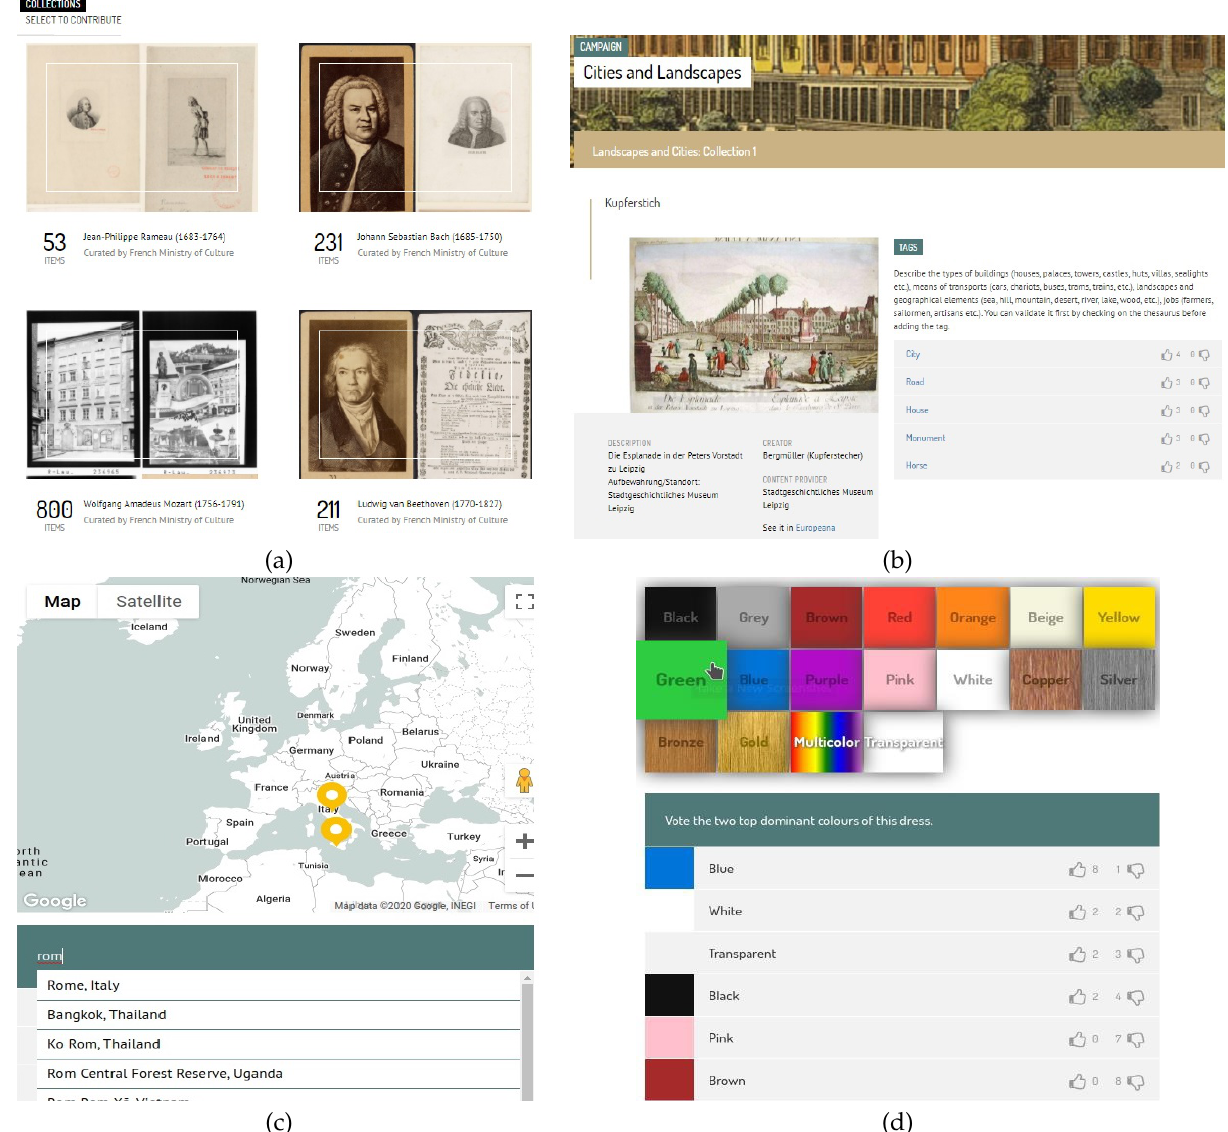
Figure 3. Annotation process: ( a ) collections, ( b ) semantic tagging, ( c ) geo-tagging and ( d )